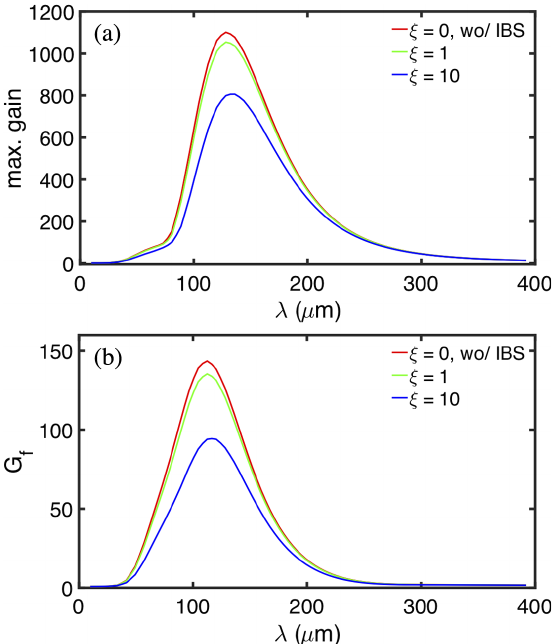
context.FIG. 8. Gain spectrum for (a) the maximum gain and (b) the gain at the exit of the recirculating beamline. Only the steady- state CSR is included in the